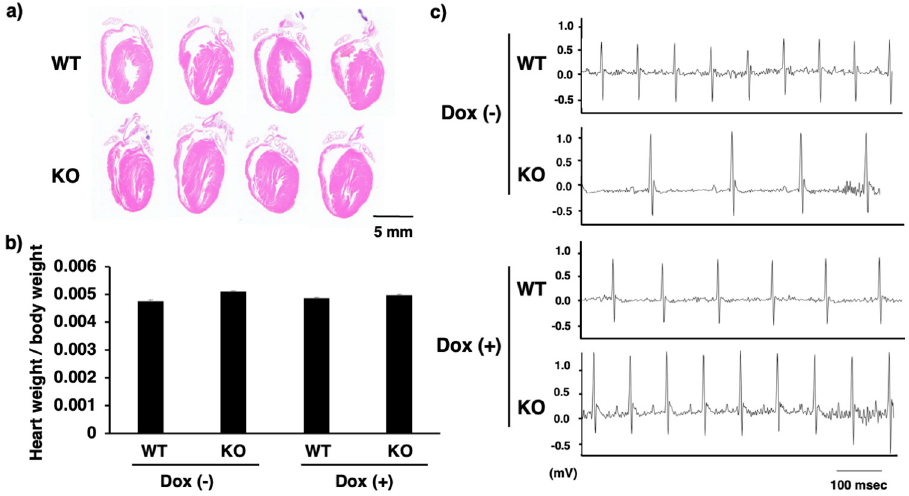
Fig 3. Cardiac analysis of Zip13 -KO mice in vivo . (a) Histological analysis of steady-state heart tissue from WT and Zip13 -KO mice. Heart tissue samples were sectioned longitudinally and stained with hematoxylin and eosin (n = 4). (b) Heart tissue weights of WT and Zip13 -KO mice injected with or without Dox (normalized to body weight). n = 3 to 4. (c) Representative heartbeat analysis in either WT or Zip13 -KO mice injected with or without Dox was monitored using the telemetry ECG system, as described in Materials and Methods. n = 3 to 4. Scale bar 100 ms.